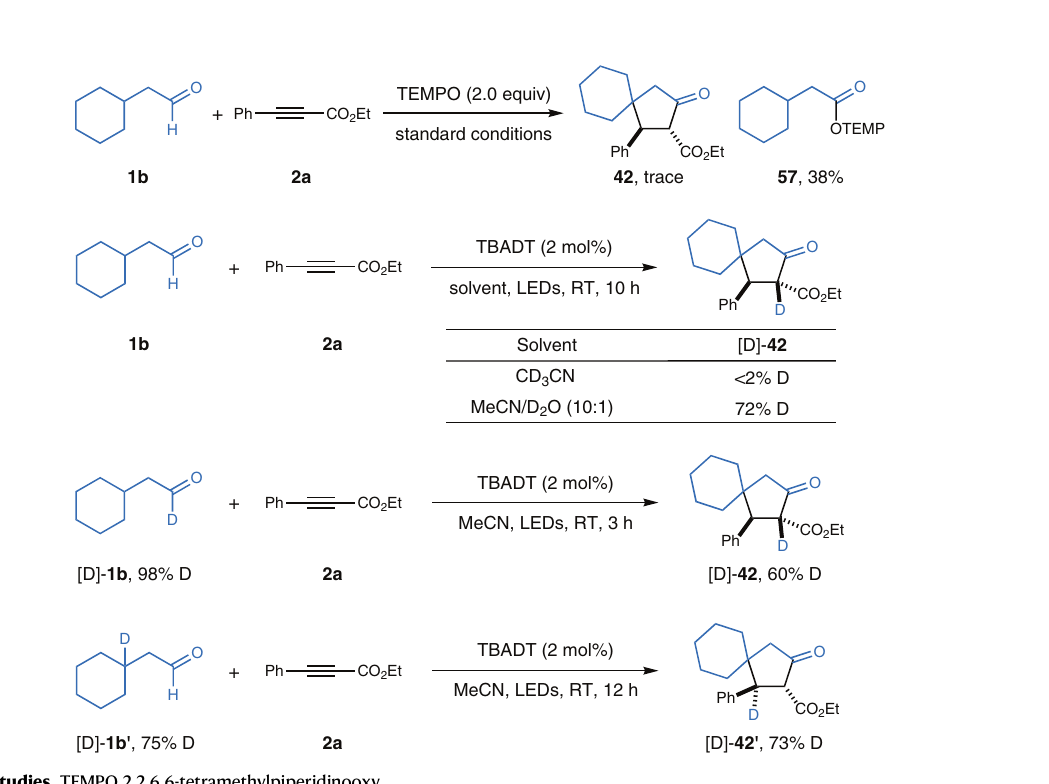
Fig. 5. Initially, the excited-state catalyst *[W 10 O 32 ] 4 − , obtained by pho- toexcitation of the decatungstate anion at 390nm, abstracts a hydro- gen atom from aldehydes to form acyl radicals I and [W 10 O 32 ] 5 − H + .